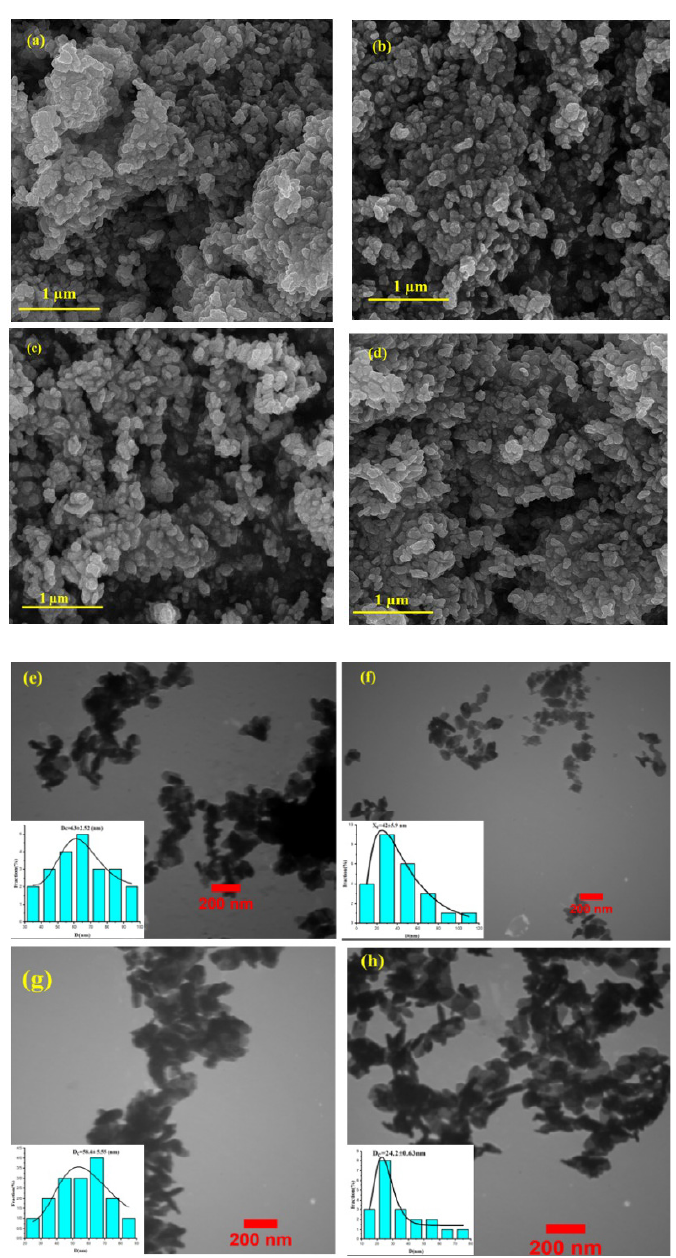
Figure 3 (a, b, c, d). FE-SEM image of CWO, CWO: Gd, CWO: Ag, and co-doped CWO nanopowders (e, f, g, h). TEM image of CWO, CWO: Gd, CWO: Ag, and co-doped CWO nanopowders, insets are particle size distribution.